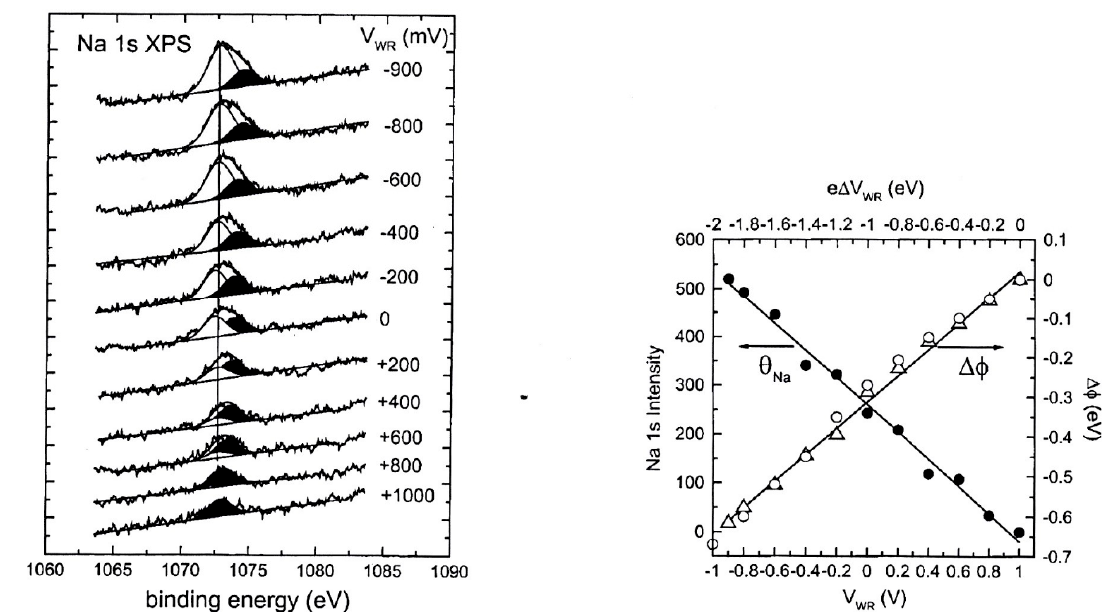
Figure 24. Na 1s XPS spectra versus catalyst potential (V WR ) for Rh film interfaced with (Na) β ”Al 2 O 3 Na + -ions conductor, at 307 ◦ C and UHV conditions. The inset shows the integrated Na1s XPS intensity due to sodium on the Rh surface and associated work function change of the Rh film as a function of V WR . Data was acquired using a Rh/(Na) β ”Al 2 O 3 /Au galvanic cell (Reproduced with permission from Ref. [51]. Copyright 2001, American Chemical Society).